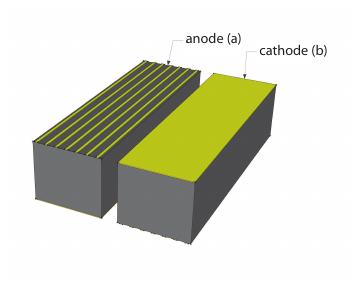
Figure 4. Drift strip gamma ray detector: anode ( a ) and cathode ( b ).